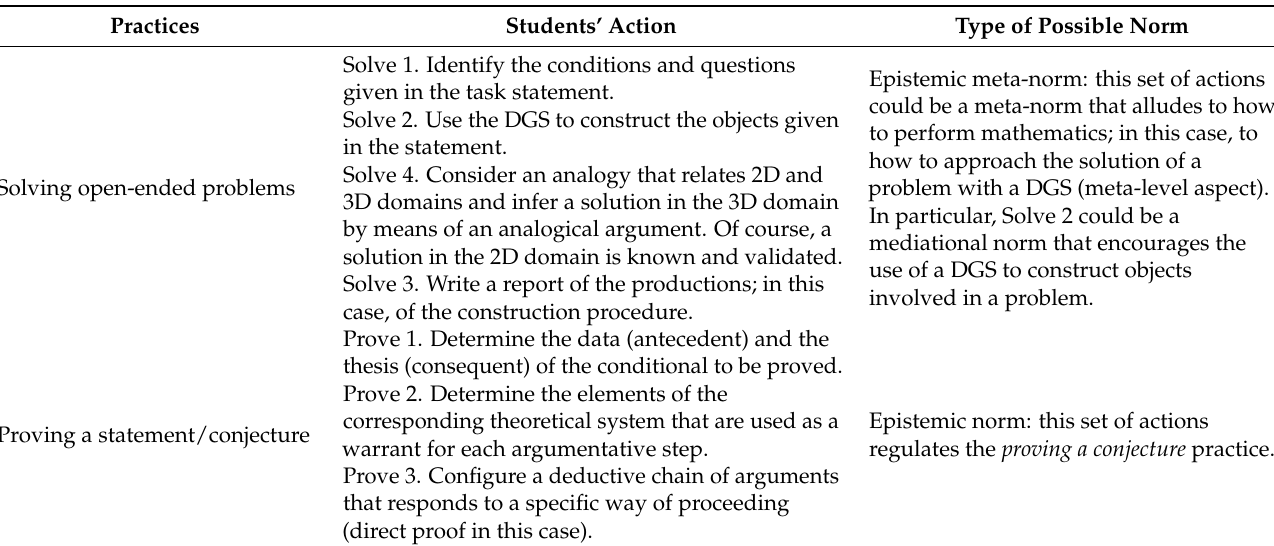
Table 3. Students’ actions that could be